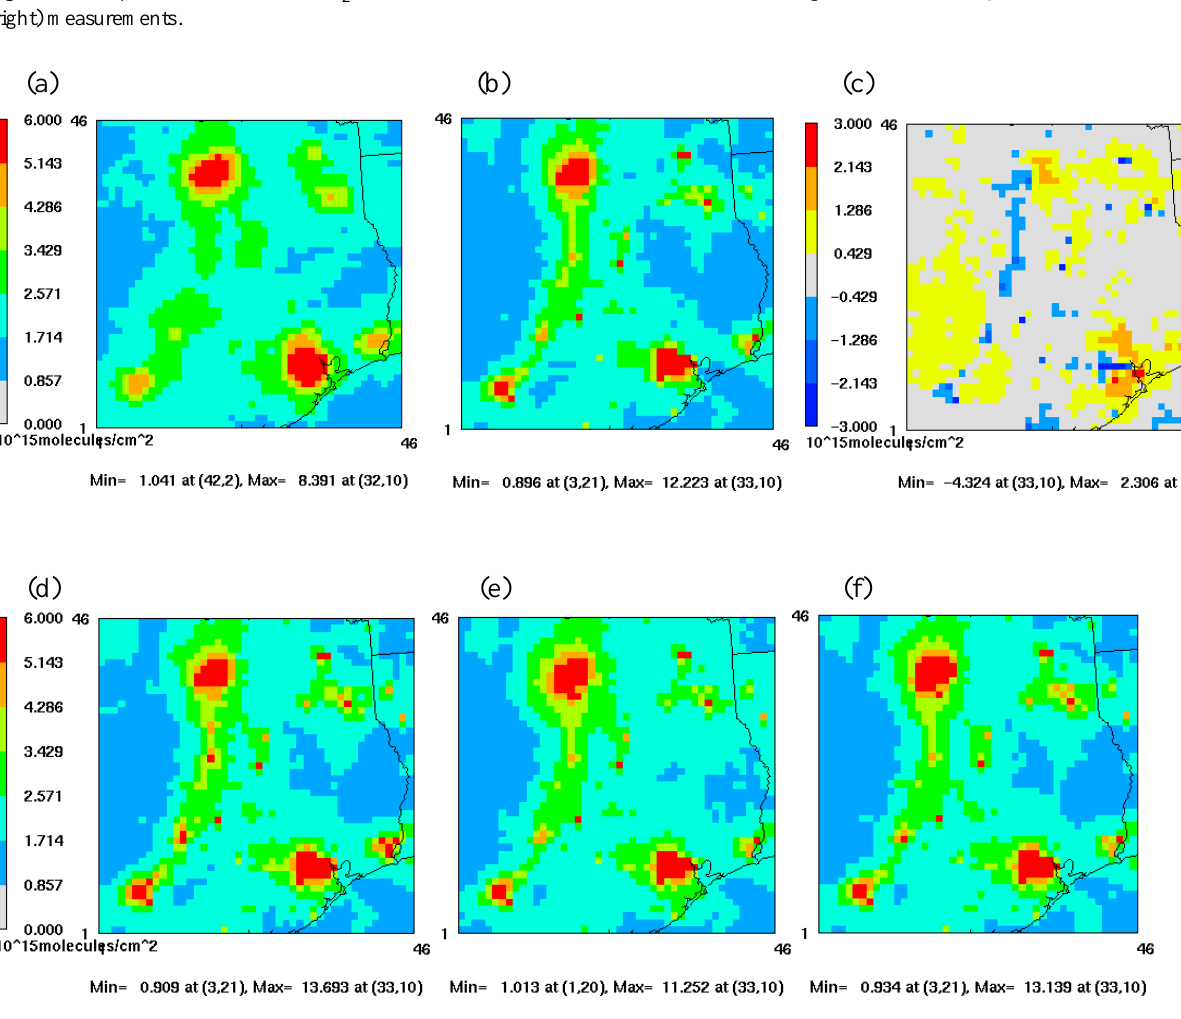
Figure 8. Monthly averaged (16 August to 15 September) tropospheric NO 2 VCDs at 13:00–14:00LT from (a) OMI, (b) a priori simulation, (c) difference between OMI and a priori simulation, and simulations using a posteriori NO x emissions generated by (d) region-based DKF inversion and sector-based DKF inversion (e) case I and (f) case